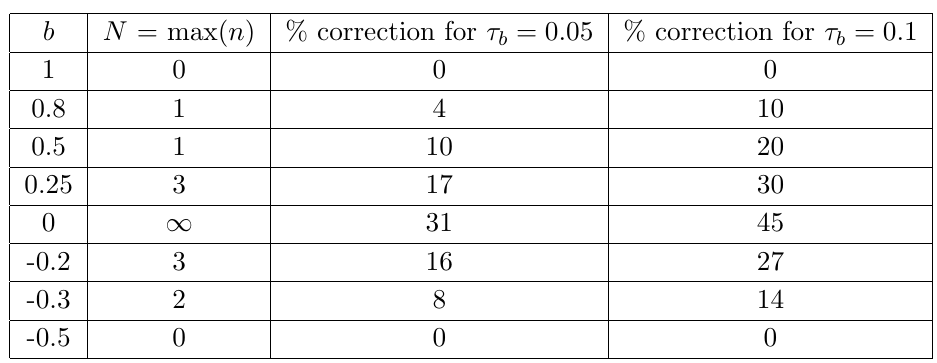
Table 1 . Relative size of the sum of the sub-leading singular terms compared to the leading singular contribution in the peak region for the (cid:28) b distribution, for various values of b , see eq. (5.12) and eq. (5.28). For a given b , N denotes the maximum value of the summation index n up to which the sub-leading terms are